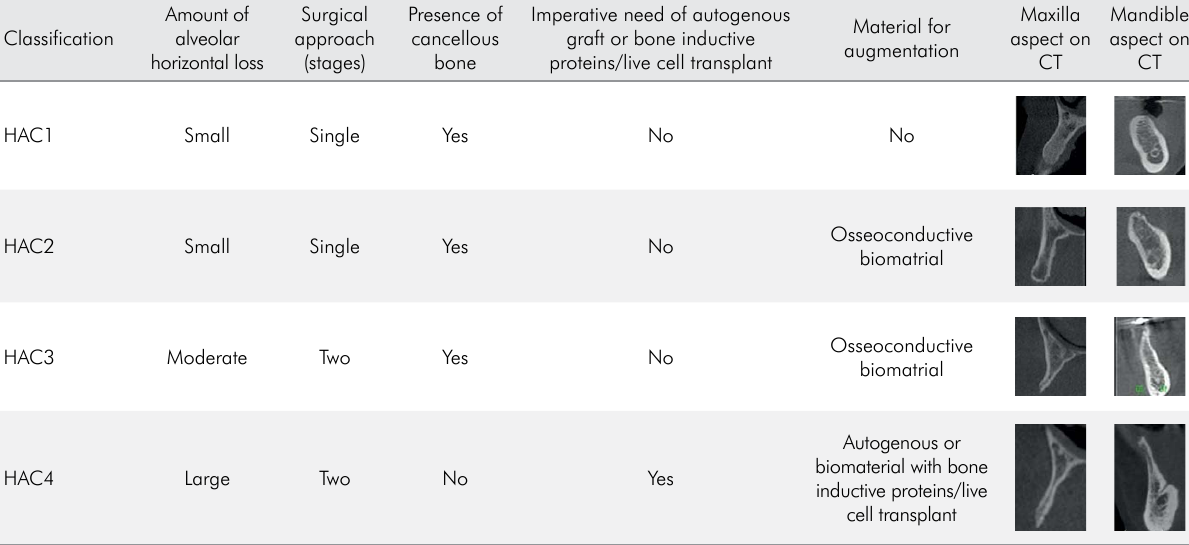
Table 4. Horizontal Alveolar Change (HAC)